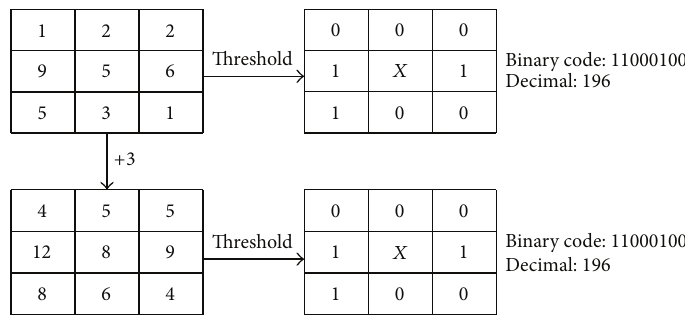
Figure 5: The principles of LBP descriptor and gray-scale invariant.